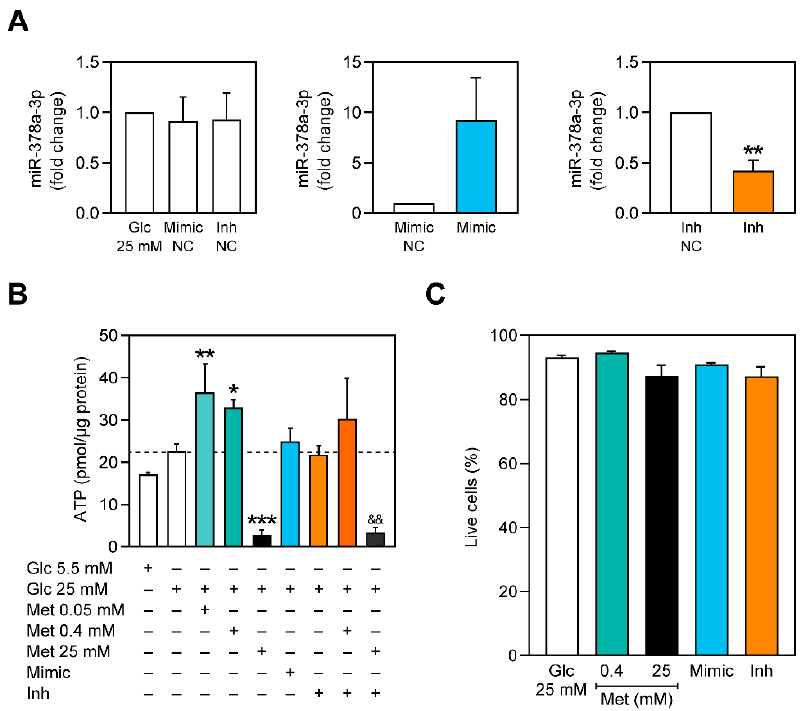
Figure 2. Lower concentrations of metformin increase ATP content in C2C12 myoblasts but this effect is impaired in cells with miR-378a-3p inhibited. ( A ) Expression levels of miR-378a-3p after transfection with mimic and inhibitor negative controls (Mimic NC and Inh NC, respectively), and with miR-378a-3p mimic and inhibitor in cells exposed to glucose 25 mM for 3 days. ( B ) ATP content in C2C12 myoblasts. ( C ) Cell viability assay using the Live/Dead viability/cytotoxicity assay kit. All data is given as mean ± S.E.M. ( n = 3). * p < 0.05 versus Glc 25 mM, ** p < 0.01 versus Glc 25 mM, *** p = 0.0006 versus Glc 25 mM, && p = 0.0035 vs Inh.